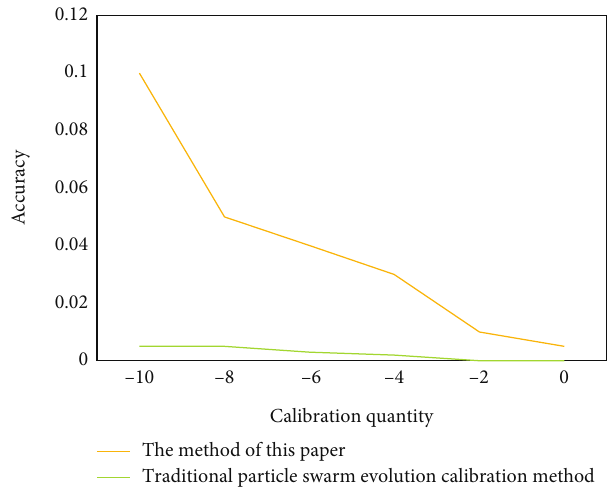
Figure 5: Comparison results of automatic calibration accuracy of two